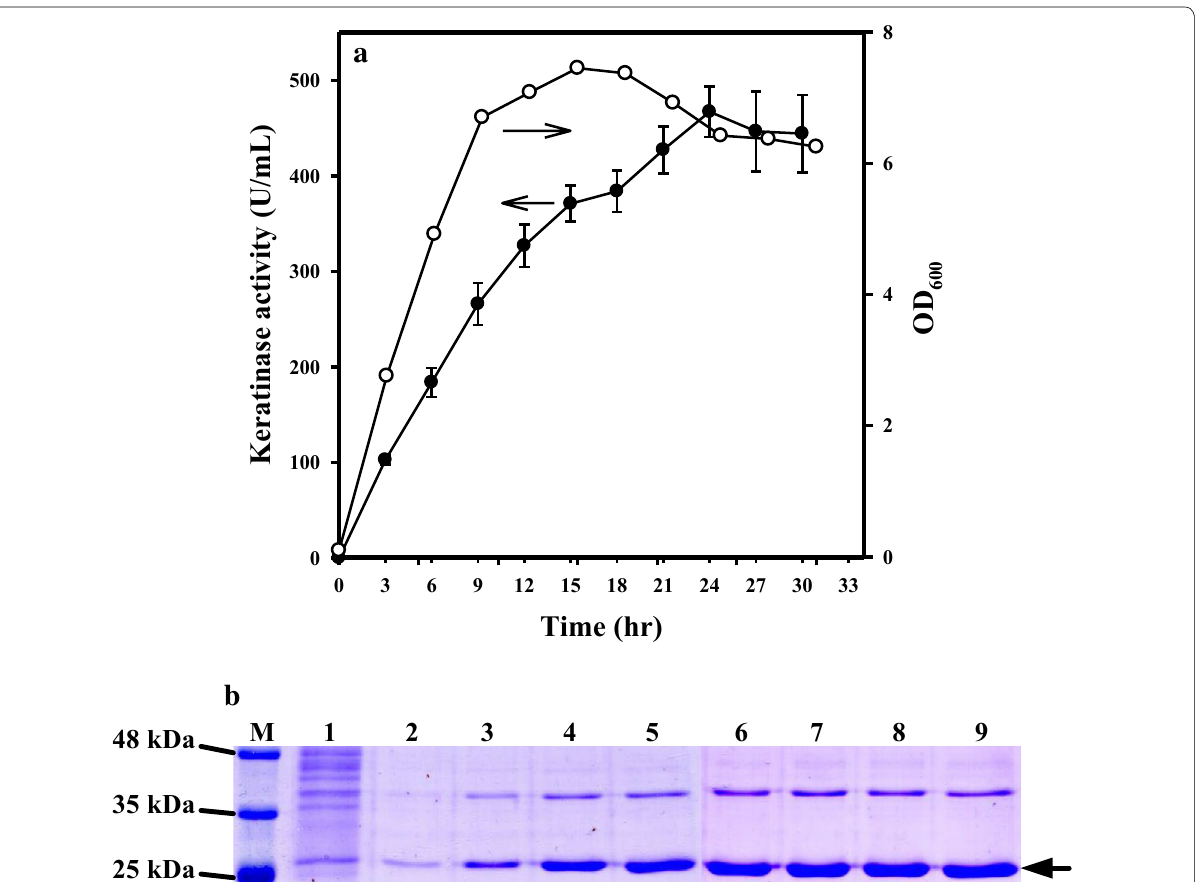
Fig. 4 a Batch fermentation of recombinant KerP‑producing strain PT5(DMT01‑mKerP) in a 5‑L fermenter. Cell density was determined during fermentation (closed circles) at OD 600 , and the production of KerP was assayed through measurement of keratinolytic activity (open circles). b SDS‑PAGE analysis of KerP secreted by recombinant B. subtilis PT5(DMT01‑mKerP). Fifteen microliters of culture broth from different fermenta‑ tion periods was drawn out for PAGE. Lanes M, protein marker; lane 1, the culture broth of PT5 after 24‑h fermentation; the culture broth of strain PT5(DMT01‑mKerP) after fermentation for lane 2, 3 h; lane 3, 6 h; lane 4, 9 h; lane 5, 12 h; lane 6, 15 h; lane 7, 18 h; lane 8, 21 h; and lane 9, 24 h. The arrow indicates the position of